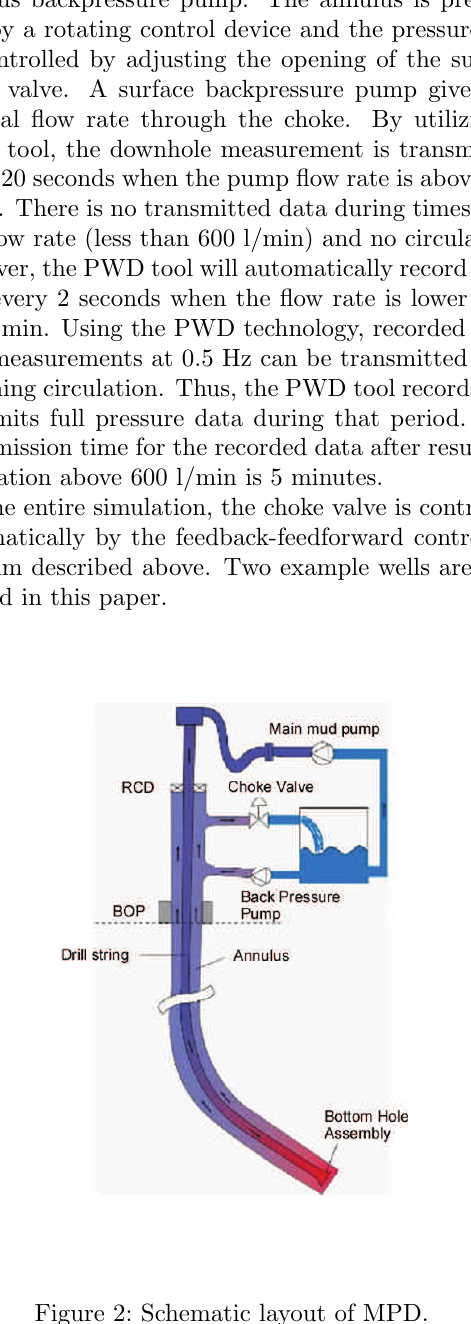
Figure 2: Schematic layout of